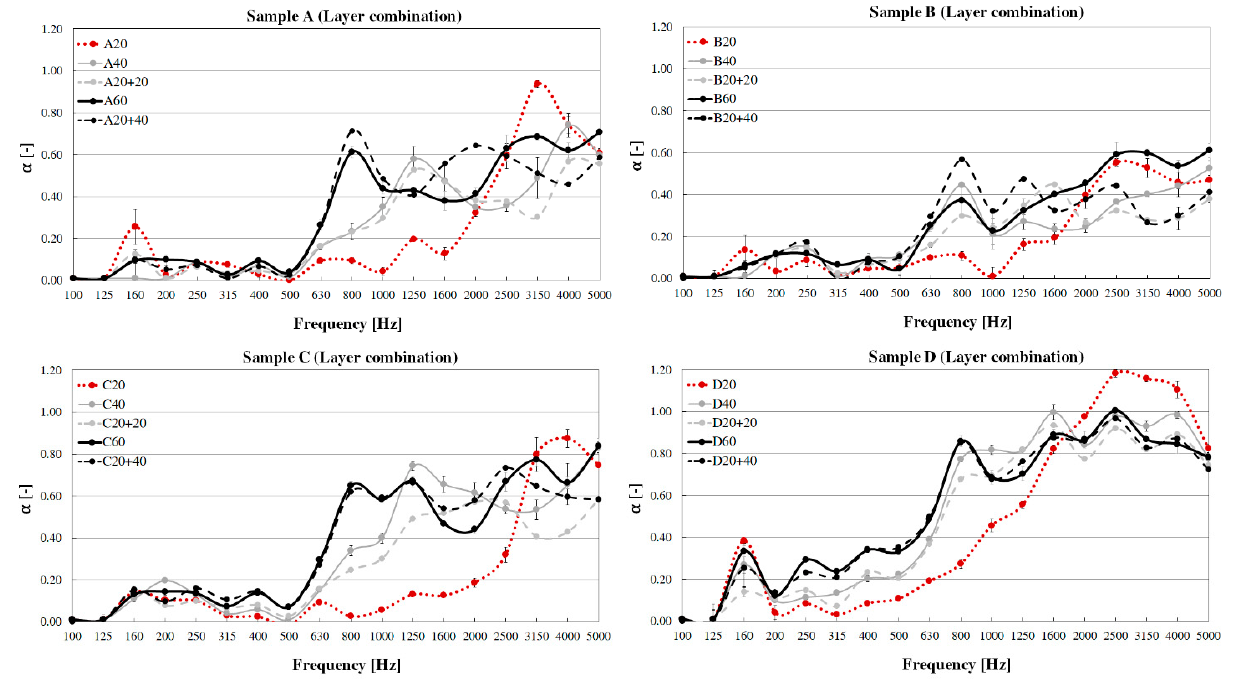
Figure 5. Comparison of the absorption coefficients for samples ( A – D ) with different thicknesses obtained from multiple layer combinations (20, 40, 20 + 20, 60, and 20 + 40 mm). Sample ( A ): crushed normal weight aggregates 4–8 mm; Sample ( B ): round lightweight aggregates 4–8 mm; Sample ( C ): round lightweight aggregates 2–4 mm; Sample ( D ): round lightweight aggregates 0.5–1 mm.